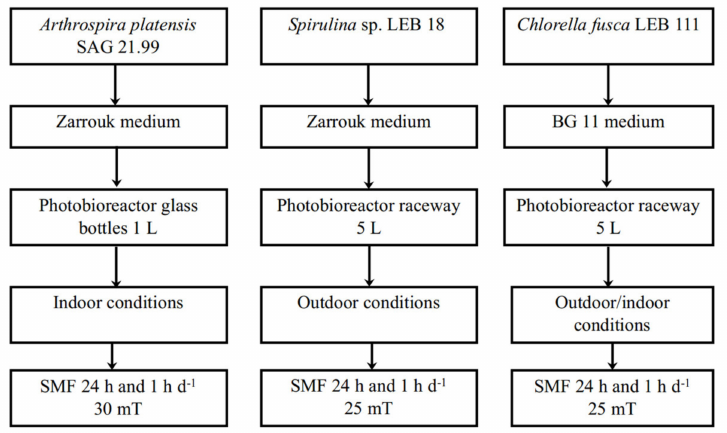
Figure 1. Scheme of research design